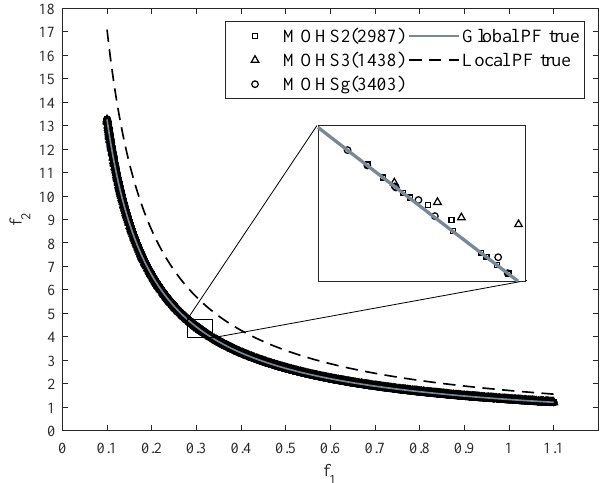
Figure 10. Pareto fronts for problem